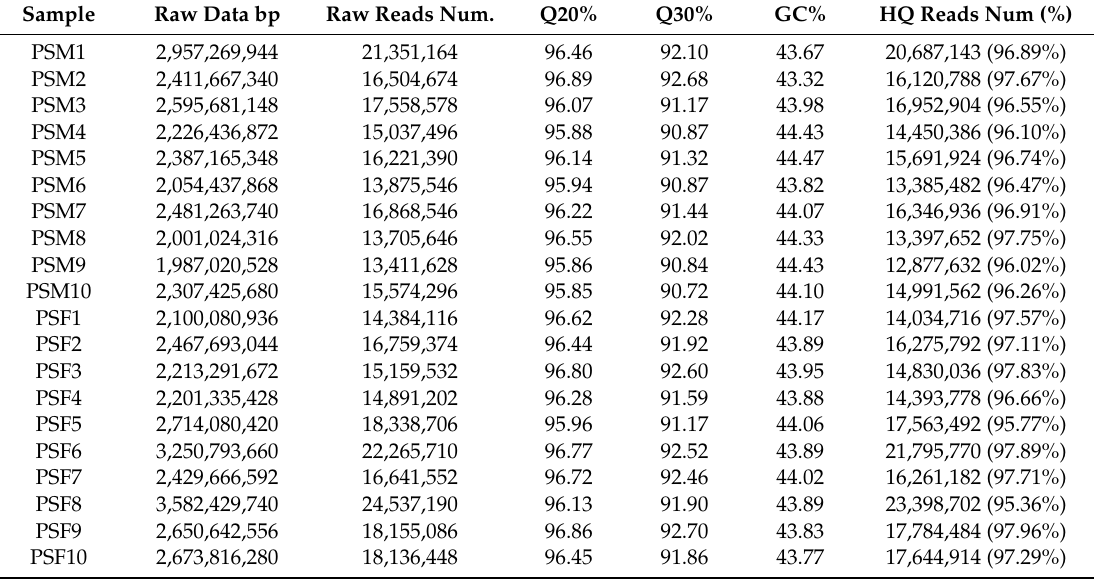
Table 2. Raw data information from